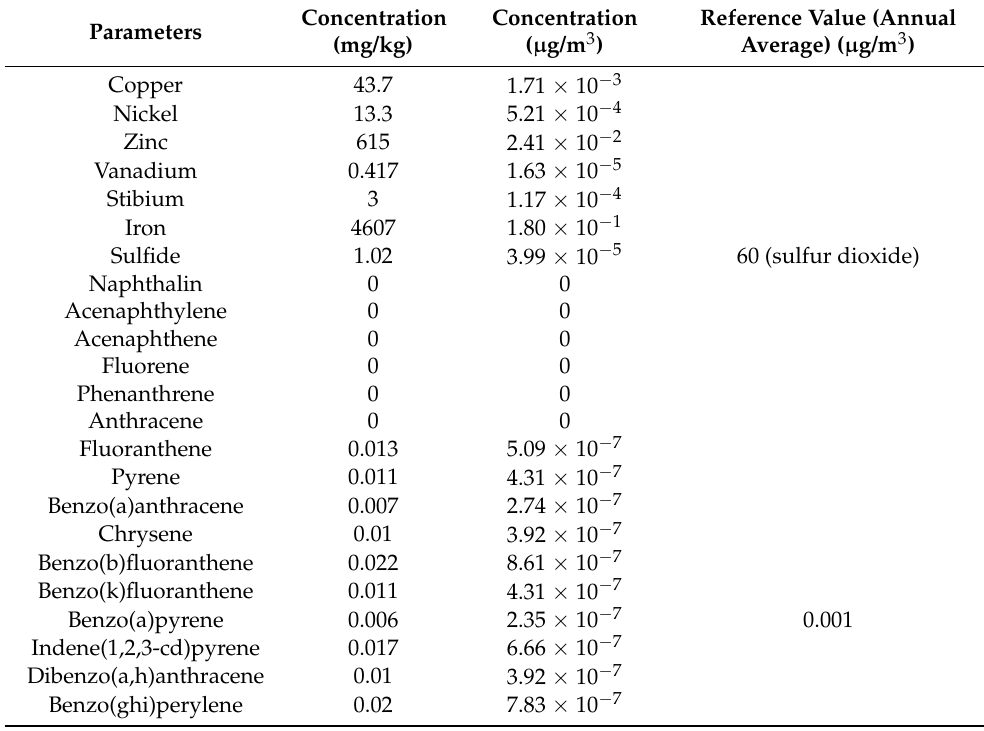
Table 2. The chemical composition of PM2.5 collected in Shanghai. Concentration Parameters